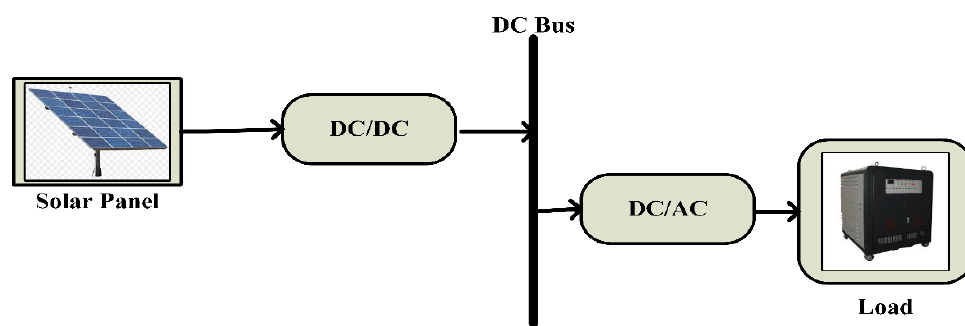
Figure 6. Block diagram of a conventional PV – battery system [51].